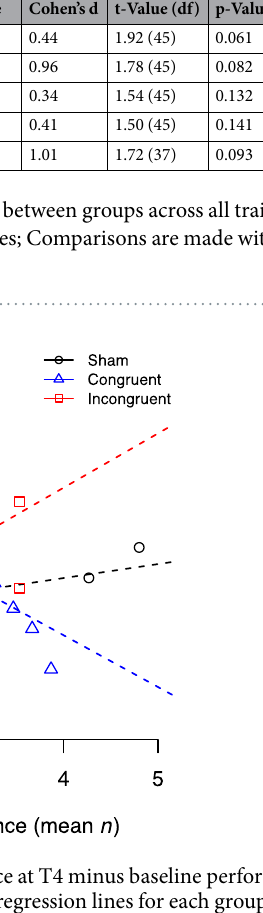
(Fig. 3). Regression parameter revealed that participants with greater baseline performance reached higher post session scores ( β formance of the untrained near-transfer task revealed an advantage of the congruent-group when compared to sham (t(33) = 2.35, p = 0.025). Correlation between baseline performance and sample characteristics.